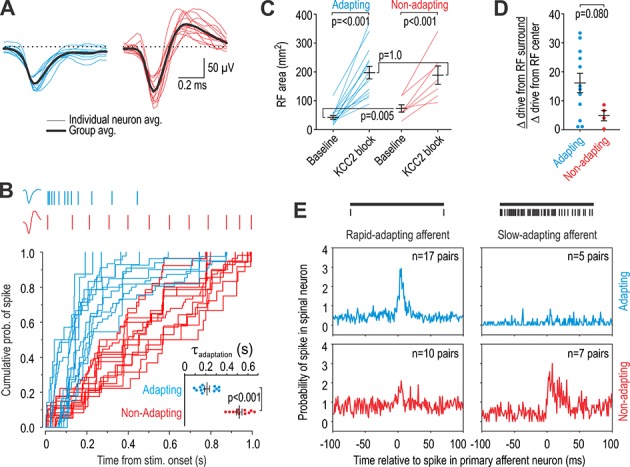
Units recorded in vivo can be divided into two groups.(A) Spike waveforms were separated according to their monophasic (blue) or biphasic (red) shape. (B) Units subdivided by spike waveform also differed in their adaptation pattern, as illustrated by sample rasters showing responses to 1 s-long 10 g von Frey stimulation (top). The cumulative probability of spiking was fit for each unit with the curve y = 1/(1-e-t/τ). The adaptation time constant τ differed significantly between groups (T23 = 8.58, p<0.001; unpaired t-test). Units are henceforth referred to as adapting (blue) or non-adapting (red). (C) Adapting units had a significantly smaller RF than non-adapting units at baseline (Q21 = 17.5, p=0.013; Mann-Whitney test) but there was no difference in RF size after KCC2 blockade (Q21 = 49.0, p=0.83). RF size was significantly affected by KCC2 blockade in both type of units (F1,20 = 66.10, p<0.001; two-way repeated measures ANOVA). Results of SNK tests are reported on graphs. (D) KCC2 blockade caused a larger, though not quite significant, increase in drive from the RC center relative to the RF surround in adapting units compared with non-adapting units (T14 = 1.89, p=0.080; unpaired t-test). (E) Cross-correlograms were calculated from all pairs of simultaneously recorded primary afferent neurons and spinal neurons with overlapping RFs. The number of pairs is reported on each panel. Primary afferents were classified as rapid-adapting (RA, left) or slow-adapting (SA, right); rasters show sample responses to 1 s-long 10 g von Frey stimulation (top). Adapting units displayed an increased probability of spiking after RA spikes (top left) but not after SA spikes (top right) whereas non-adapting units displayed a large increase in spike probability after SA spikes (bottom right) and a modest increase after RA spikes (bottom left). In other words, adapting units receive input exclusively from RA afferents whereas non-adapting units receive input preferentially from SA afferents.Figure 2—source data 1.Numerical values for data plotted in Figure 2.